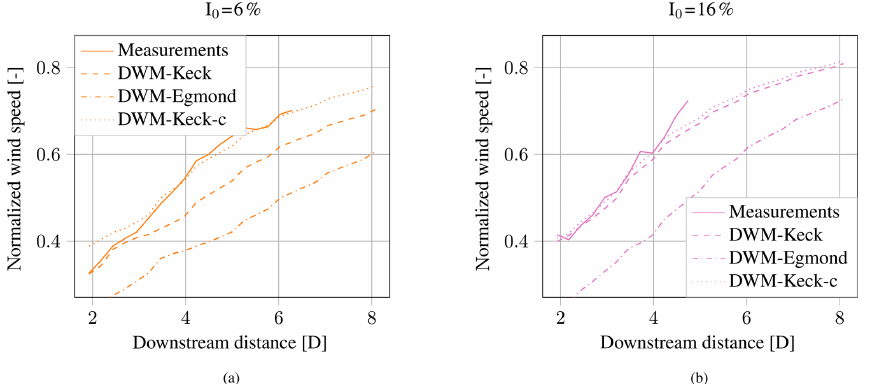
Figure 13. Comparison of measurements and simulations of the minimum wind speed deficit in the HMFR for different turbulence intensi- ties. The recalibrated model is denoted